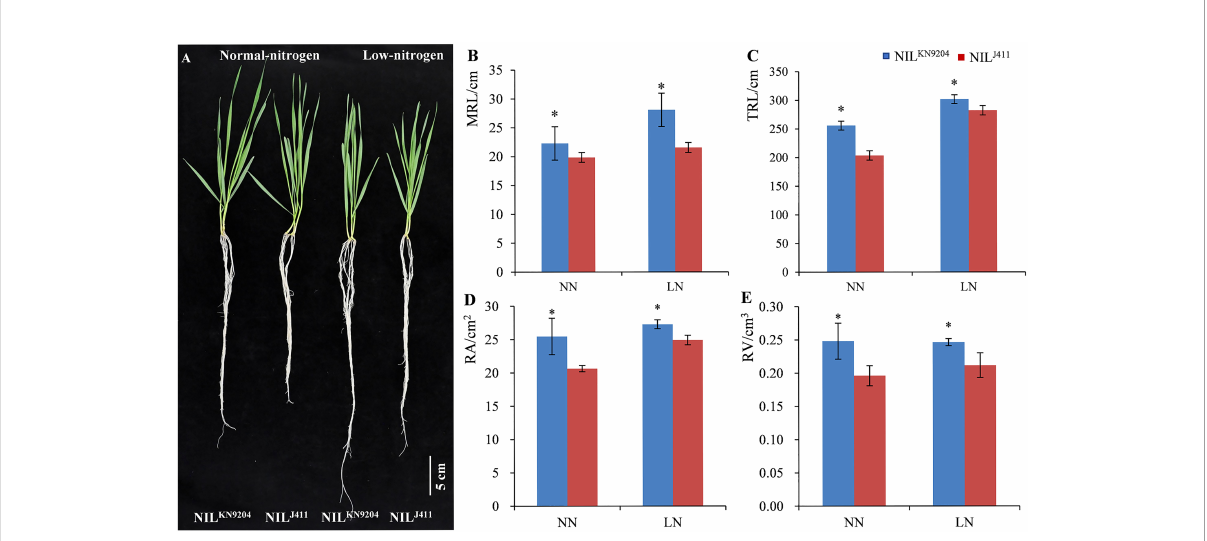
FIGURE 1 Phenotypes of four-leaf-stage seedlings (A) and the corresponding root traits (B-E) of the pairwise NILs cultured in nutrient solutions with different N contents for fourteen days NN and LN indicate normal- and low-nitrogen conditions, respectively. MRL, TRL, RA and RV indicate the maximum root length, total root length, root surface area and root volume, respectively. “ * ” indicates a signi fi cant difference at p <